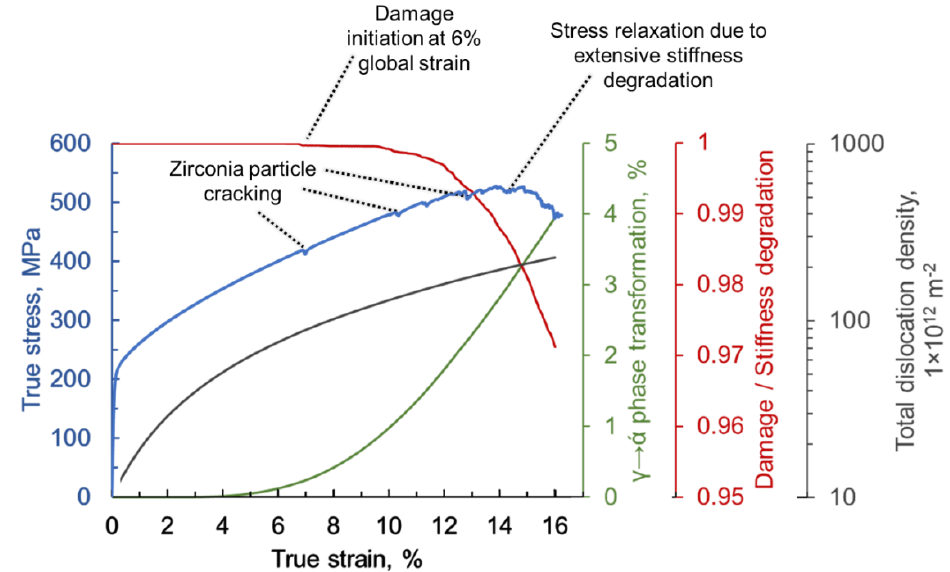
Figure 3. Averaged evolution of stress, phase transformation, stiffness degradation, and dislocation density in the austenite phase of composite material with increasing global true strain.